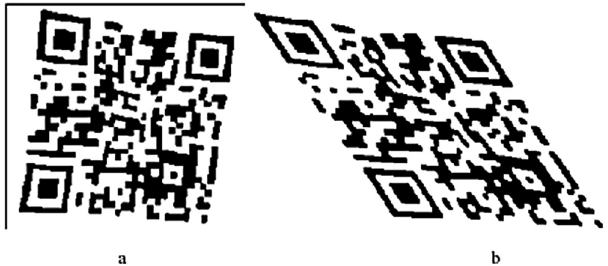
Figure 11: The result of distortion correction processing: ( a ) Before distortion correction and ( b ) After applying distortion correction